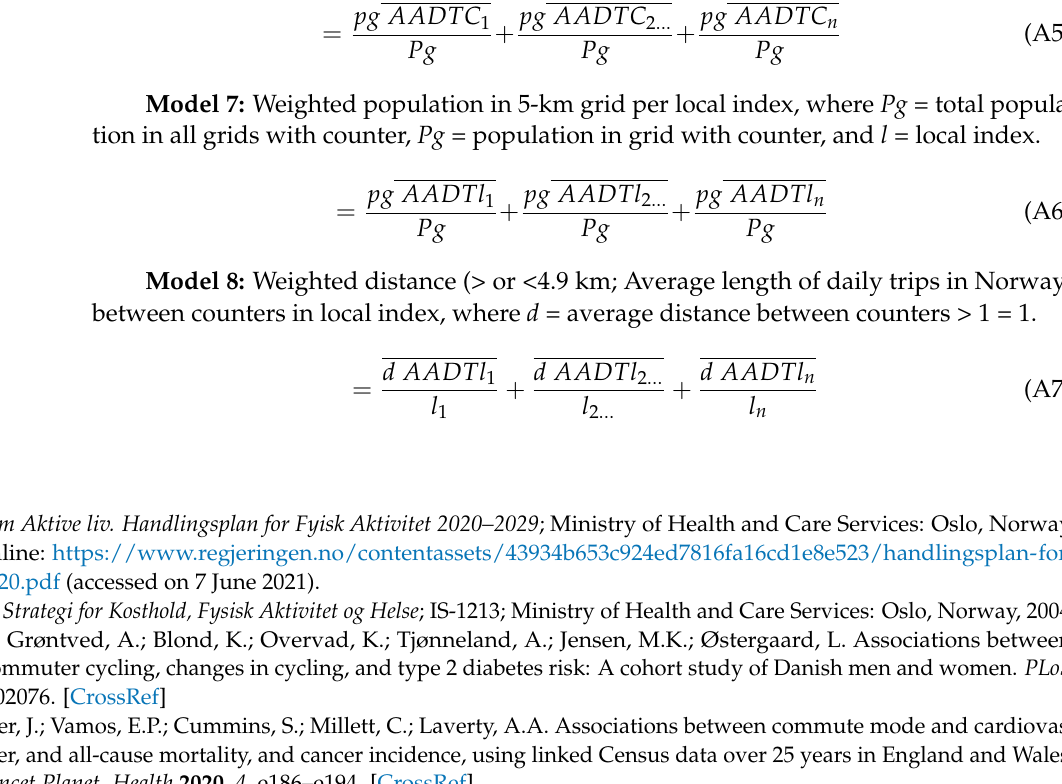
Model 7: Weighted population in 5-km grid per local index, where Pg = total popula- tion in all grids with counter, Pg = population in grid with counter, and l = local index.